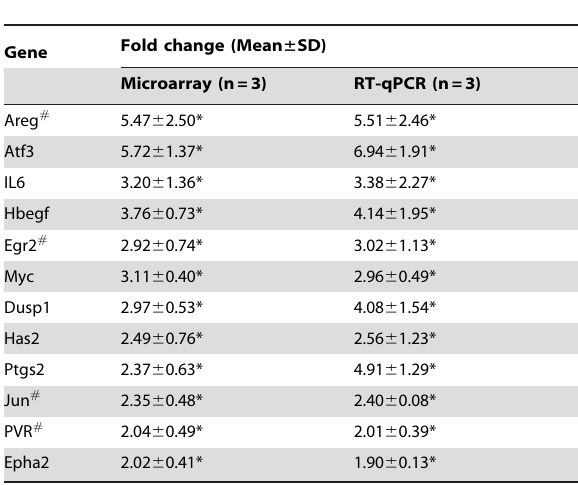
Table 6. Validation of Microarray Gene Expression at 1 h by qPCR.